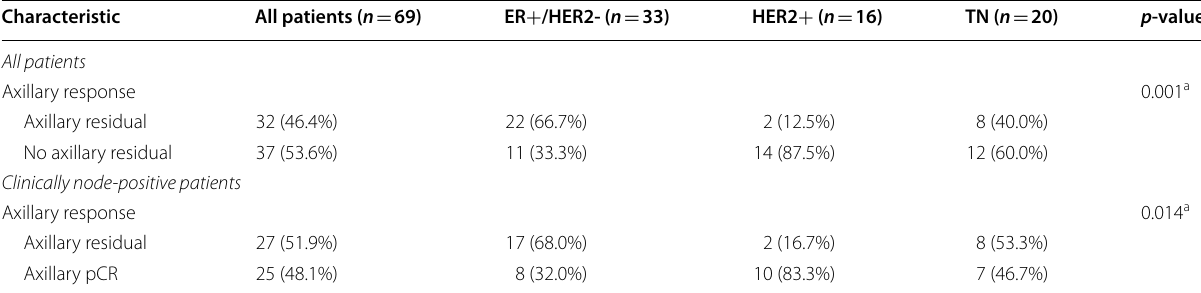
ER, estrogen receptor; HER2, human epidermal growth factor 2 receptor; pCR, pathologic complete response a Pearsons’ chi-square test; all variables are displayed as number and percentage